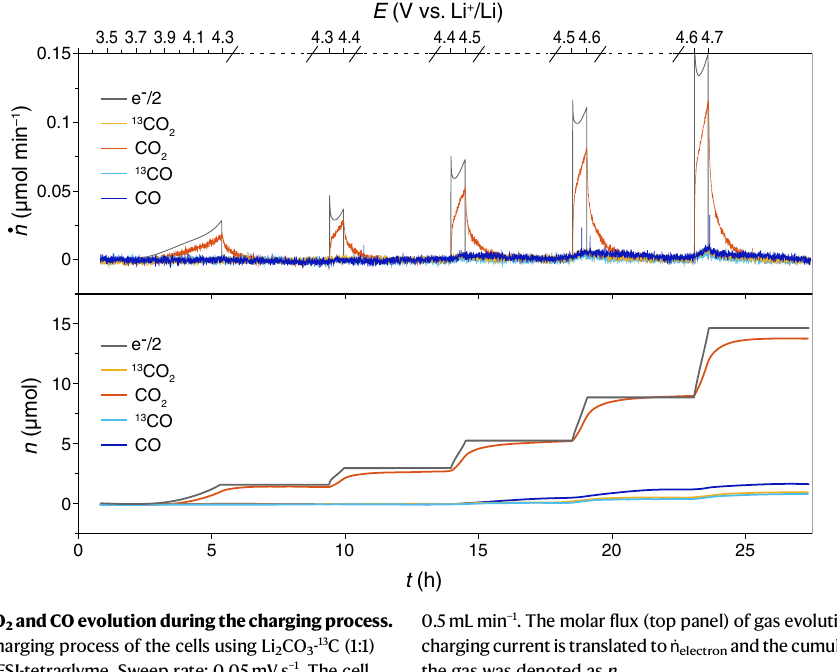
0.5mLmin − 1 . The molar fl ux (top panel) of gas evolution was denoted as ṅ and